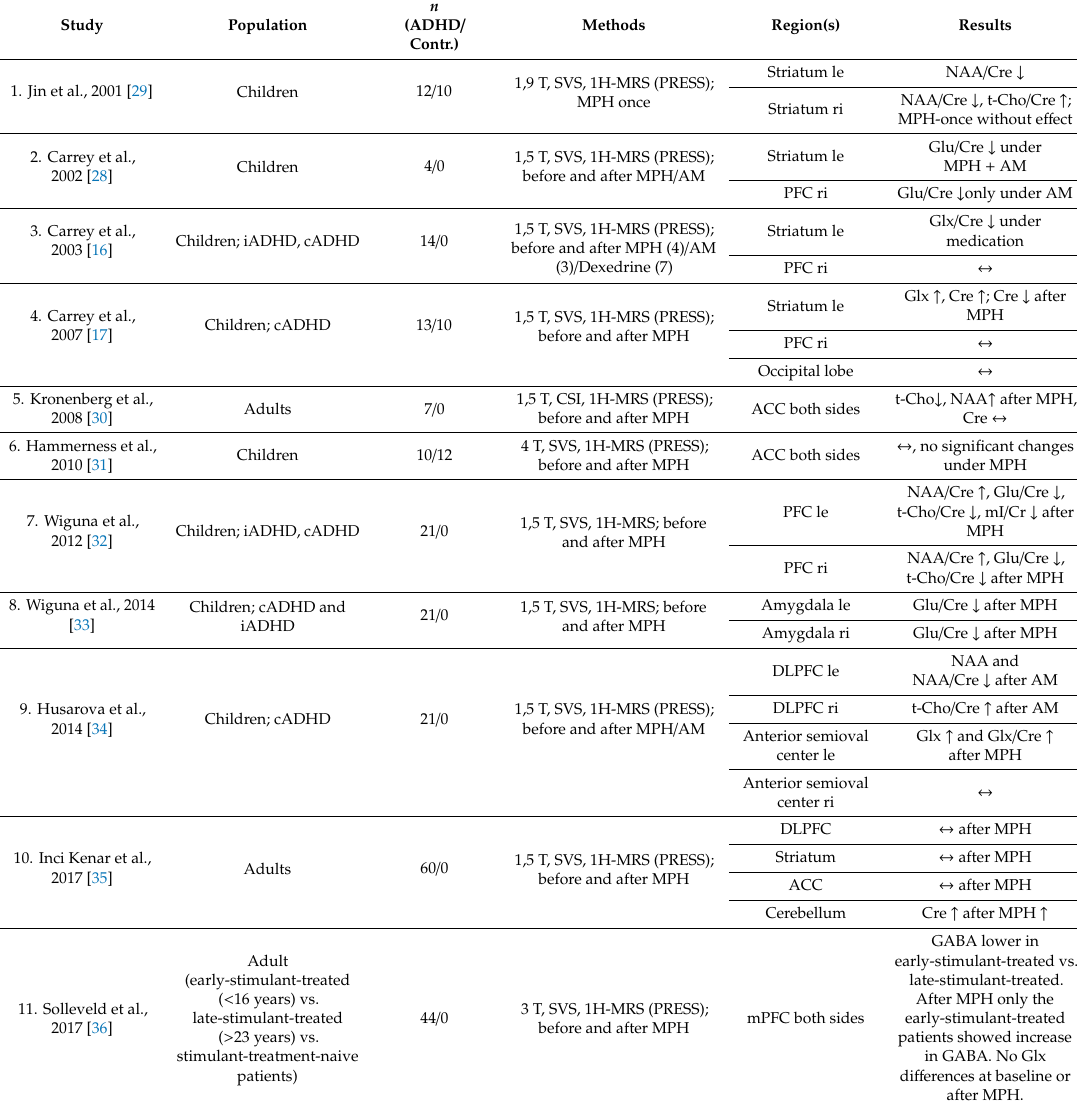
Table 1. Summary of previous magnetic resonance spectroscopy studies analyzing medication e ff ects in patients with